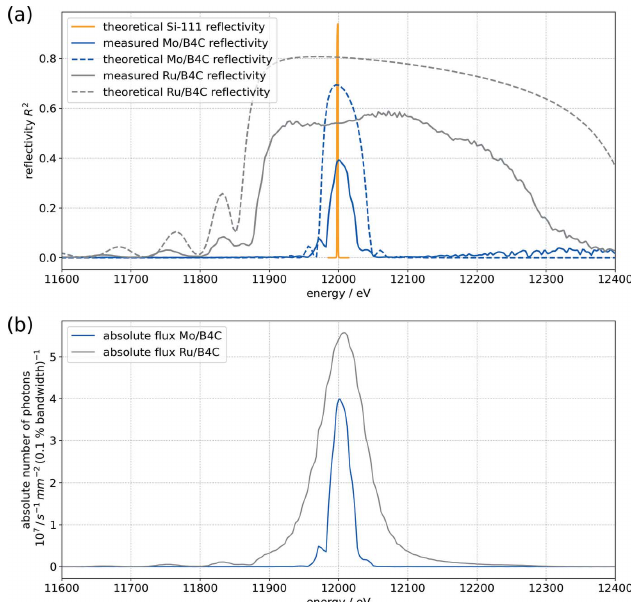
Figure 3 ( a ) Experimentally and theoretically determined reflectivity curves for double reflections of the Si-111 crystal and the Ru/B 4 C and Mo/B 4 C multilayer systems. ( b ) The flux measured at the experiment. This is the product of the monochromator reflectivity and the undulator harmonic photon flux.